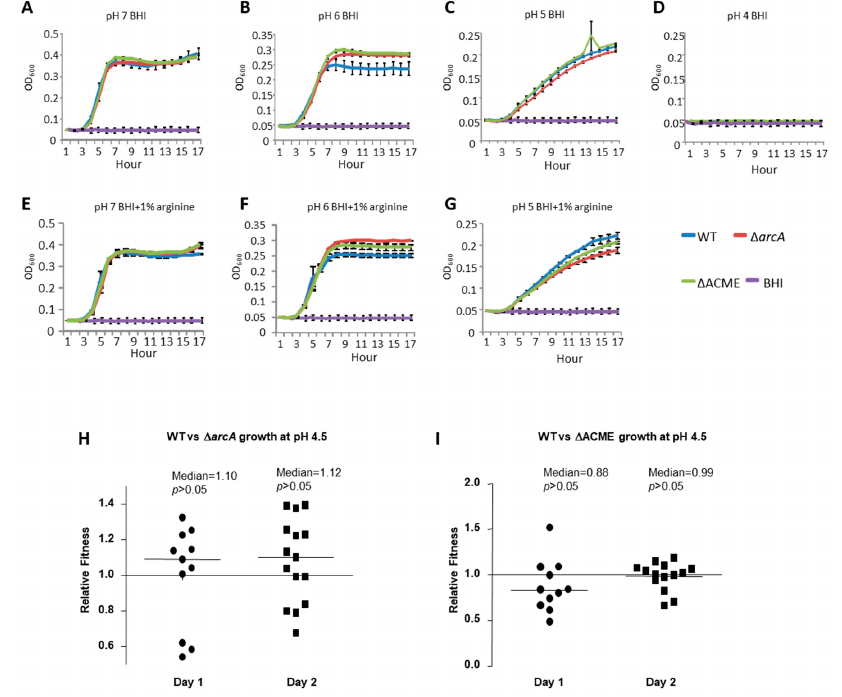
Figure 3. Growth of strain 2406 WT, ∆ arc A and ∆ ACME in acidic environment. OD 600 was plotted over time for growth of the strains in media of di ff ering pH. ( A – G ): WT, ∆ arc A, ∆ ACME growth curves in BHI at pH 7 ( A ), pH 6 ( B ), pH 5 ( C ), pH 4 ( D ), pH 7 + 1% arginine ( E ), pH 6 + 1% arginine ( F ), and pH 5 + 1% arginine ( G ). No significant di ff erence was observed between WT and mutants ( ∆ arc A and ∆ ACME). The blue curve represents the WT strain, red represents ∆ arc A, green represents ∆ ACME, and purple represents the BHI control without bacteria. ( H , I ): WT vs. ∆ arc A ( H ) and WT vs ∆ ACME ( I ) competition experiments in BHI (pH 4.5). No di ff erence observed between WT and mutants, as the means of W WT, ∆ were not significantly di ff erent from 1 on Day 1 and Day 2, respectively. Mann–Whitney tests were performed to determine significant di ff erence between the W WT, ∆ and the value 1. The bar indicated the median value of the relative